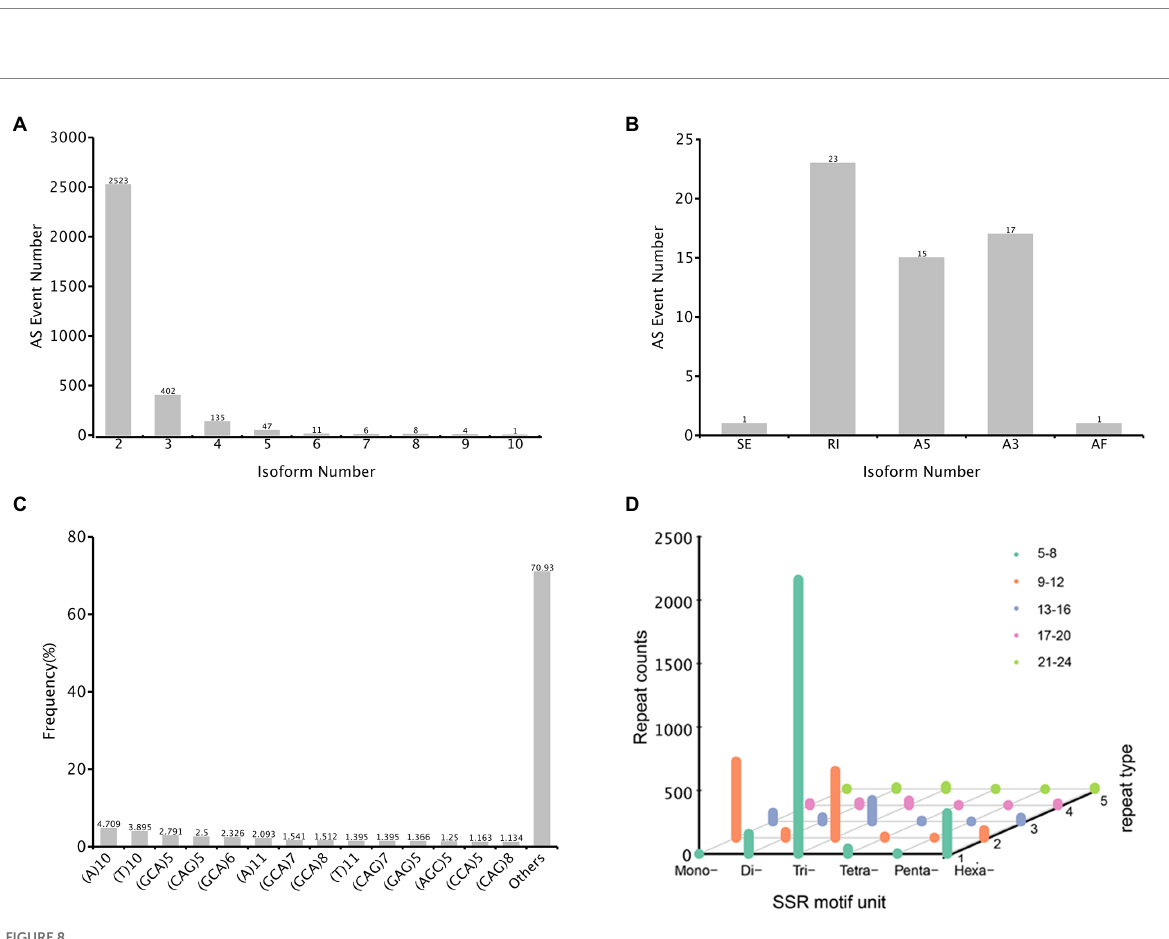
FIGURE 8 Characterization of structural annotation. (A) Distribution of alternative splicing (AS) in each isoform. (B) Count of five types of AS. (C) The distribution of simple sequence repeats (SSR) type counts. (D) SSR motif unit distribution, x -axis represented the type of motif unit, y -axis represented the count number and z -axis represented different repeat